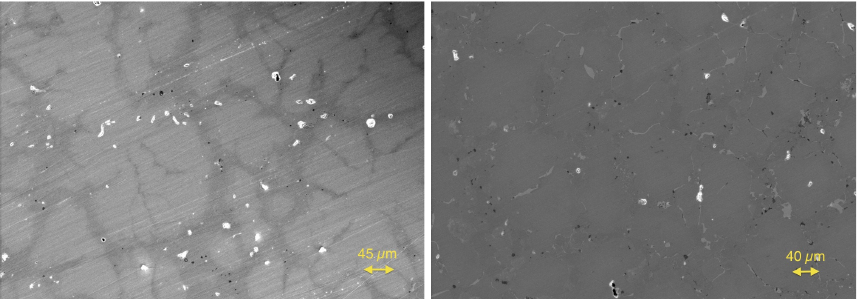
Figure 4. Scanning electron microscope images of Ti 0.4 Zr 0.6 NiSn ( left ) and Ti 0.6 Zr 0.4 NiSn ( right ). Table 3. The phase compositions of the different Ti ( 1 − x ) Zr x NiSn samples and the parent samples. Weighed Composition